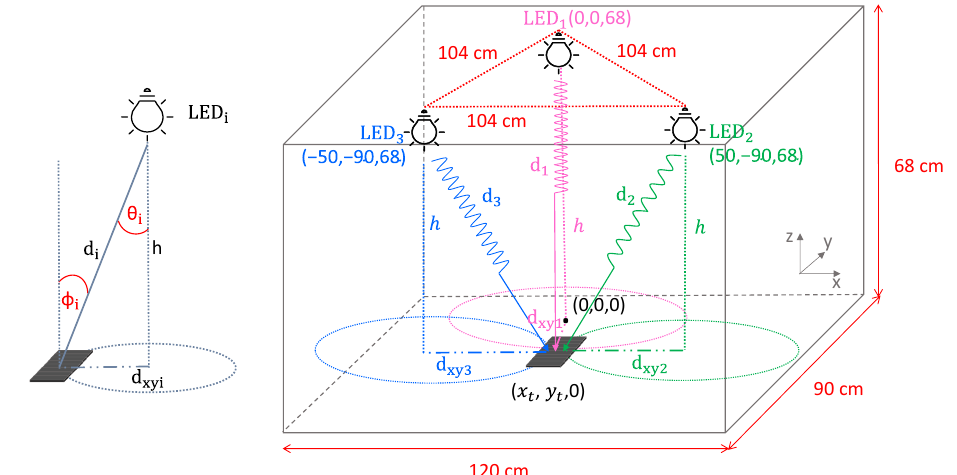
Figure 1. Geometrical representation of the adopted localization approach. The output of the FFT algorithm is a vector containing the amplitudes of the received signal in correspondence of the unique frequencies identifying the three light sources, V Ri .